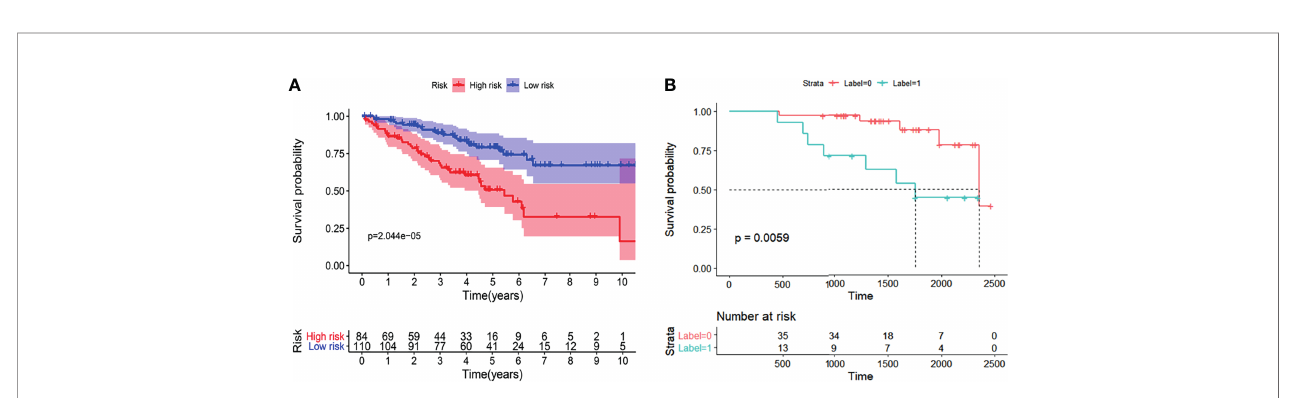
FIGURE 7 | The K-M analysis showed that the established radiogenomics biomarker could successfully divide ccRCC patients in to high- and low-risk, and possessing effective prognostic predictive ability both in the TCIA-KIRC (A) database and Huashan validation database (B)